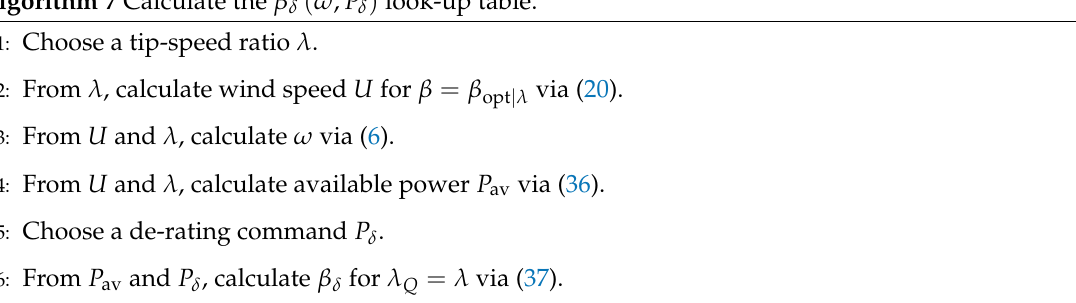
Figure 16. β δ ( ω , P δ ) tables for NREL 5-MW ( a ) and DTU 10-MW ( b ) reference turbines. Algorithm 7 Calculate the β δ ( ω , P δ ) look-up